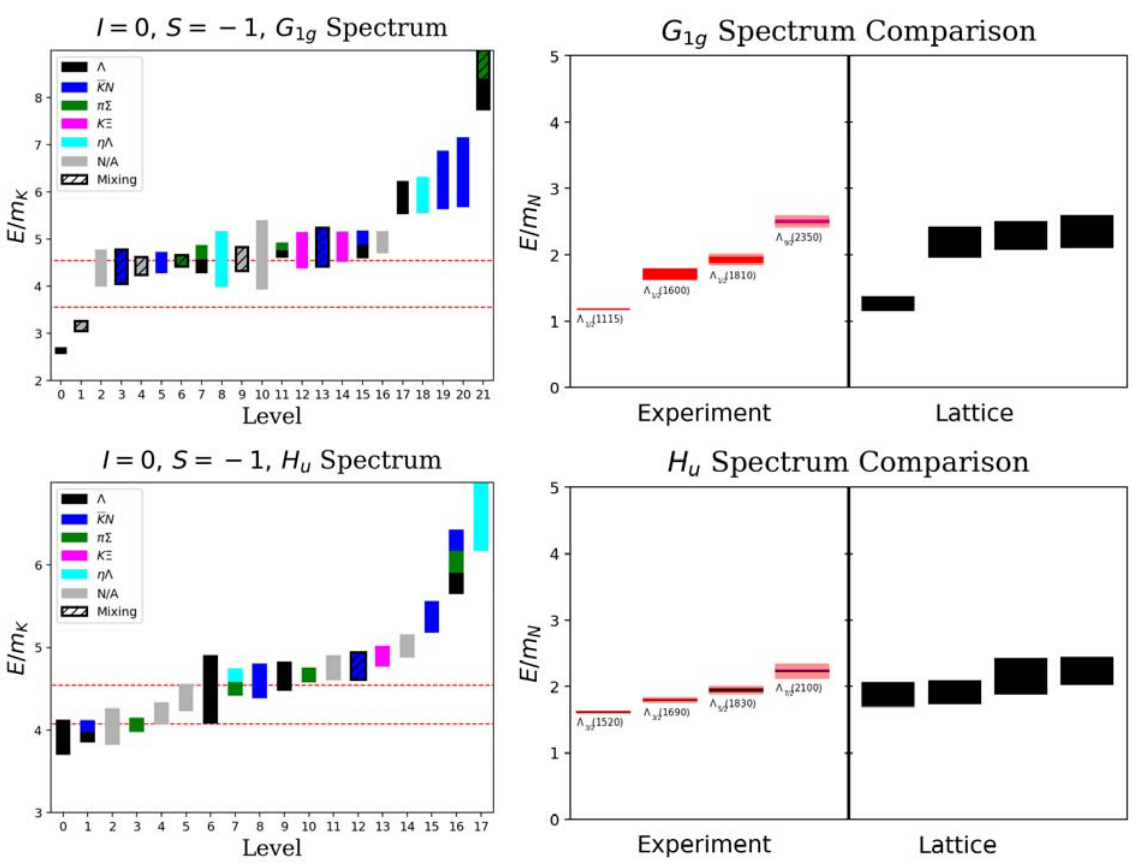
Figure 10. (Left) Stationary state energies in the I = 0 , S = − 1 baryonic flavor sector for a 32 3 × 256 anisotropic lattice with ∼ 240 MeV. The G m π 1 g channel (even parity containing the spin- are shown as ratios over the kaon mass m K . Di ff erent colors indicate the di ff erent properties of the states as deduced by the fitted overlap factors Z ( n ) j . (Right) The single-baryon dominated levels are compared to experiment as ratios over the nucleon mass m N . Results are from Ref.